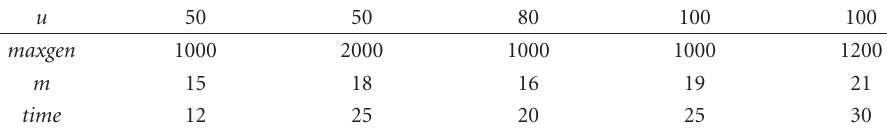
Table 4.4. Search results of 5 di ff erent parameter values for a 12-dimensional set by our approach. u